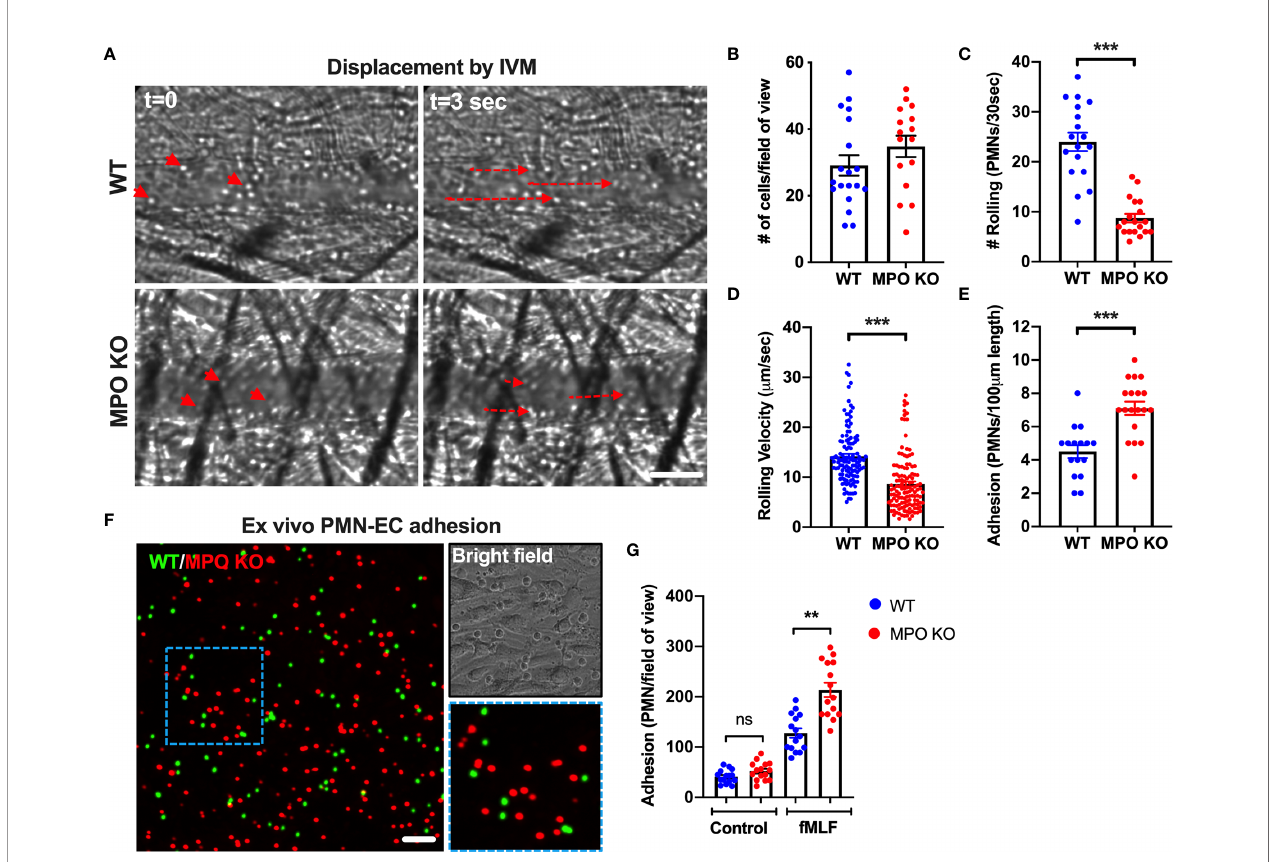
FIGURE 4 | MPO KO PMNs exhibit enhanced adhesion to in fl amed vascular endothelial cells. (A – E) To assess the role of MPO in PMN-EC interactions intravital imaging (IVM) of the cremaster muscle was performed on WT and MPO KO mice. In fl ammation of the cremaster muscle was induced by intrascrotal administration of IL-1 b (50ng, 4hr). (A) Representative time-lapse images (based on a real-time acquisition) show decreased displacement of rolling PMNs in MPO KO animals. The bar is 50µm. (B) Analyses of total cell fl uxes (C) Number of rolling cells per 30 seconds (D) Rolling velocities of individual PMNs and (E) PMN adhesion reveal a signi fi cant reduction in rolling and increases in adhesive interactions in MPO KO mice. N=5 mice with 5-6 fi elds of view per condition. (F – G) Ex vivo adhesion assay of BM-PMNs and murine ECs was performed. WT and MPO KO BM-PMNs were respectively stained with green and red fl uorescence (CellTracker) and allowed to adhere to TNF a -stimulated (50ng, 24hr) Bend3 ECs in the presence of fMLF stimulation (500nM). (F) Representative fl uorescent images and (G) Quanti fi cation reveal signi fi cant increases in MPO KO adhesion compared to WT. The bar is 50µm. N=3-5 independent experiments per condition. **p < 0.01, ***p < 0.001. ns, not signi fi